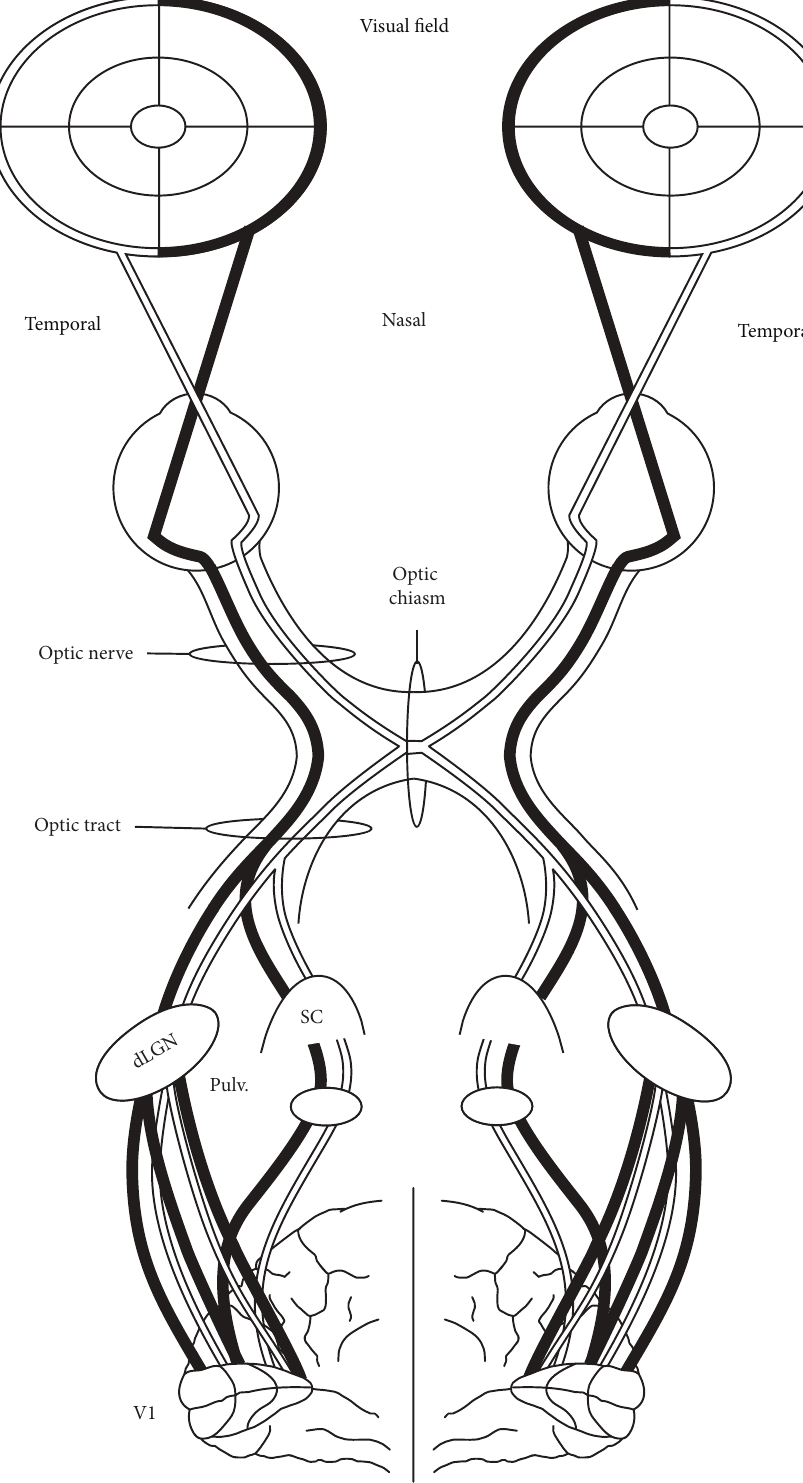
Figure 1: The main projection pathways of the primate visual system. Temporal retina receives visual input from the nasal half of the visual field, whereas nasal retina receives input from the temporal half of the visual field. The optic nerves deriving from the temporal half of the retina (black line) project ipsilaterally, whereas the nasal nerves (white line) cross at the optical chiasm and project to the contralateral hemisphere. Most of the visual fibers reach the visual cortex through relay synapses located at the dorsal lateral geniculate nucleus (dLGN) in the thalamus. A smaller percentage of visual fibers reach the primary visual cortex (V1) through the superior colliculus (SC) and pulvinar